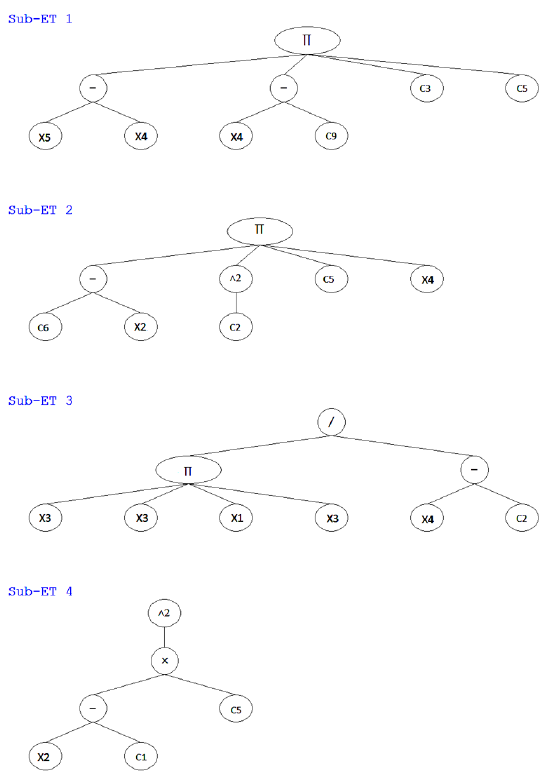
Fig. 4. Expression tree for cost estimation of sewer and water projects